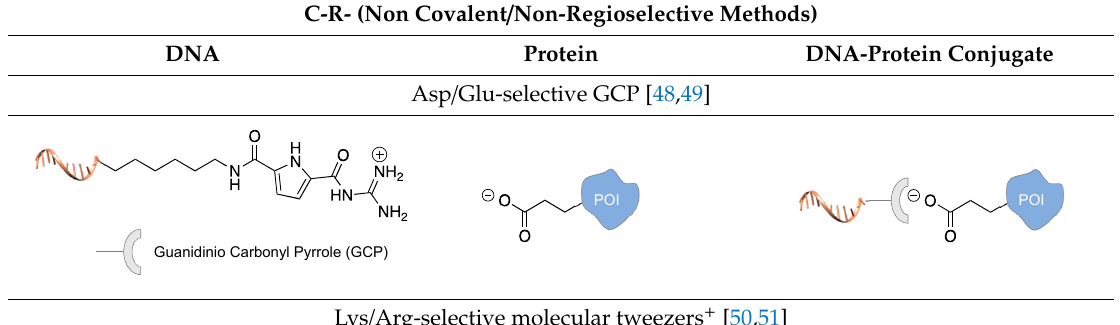
Table 3. Representative non-covalent and non-regioselective (C-R-) DNA-protein conjugation